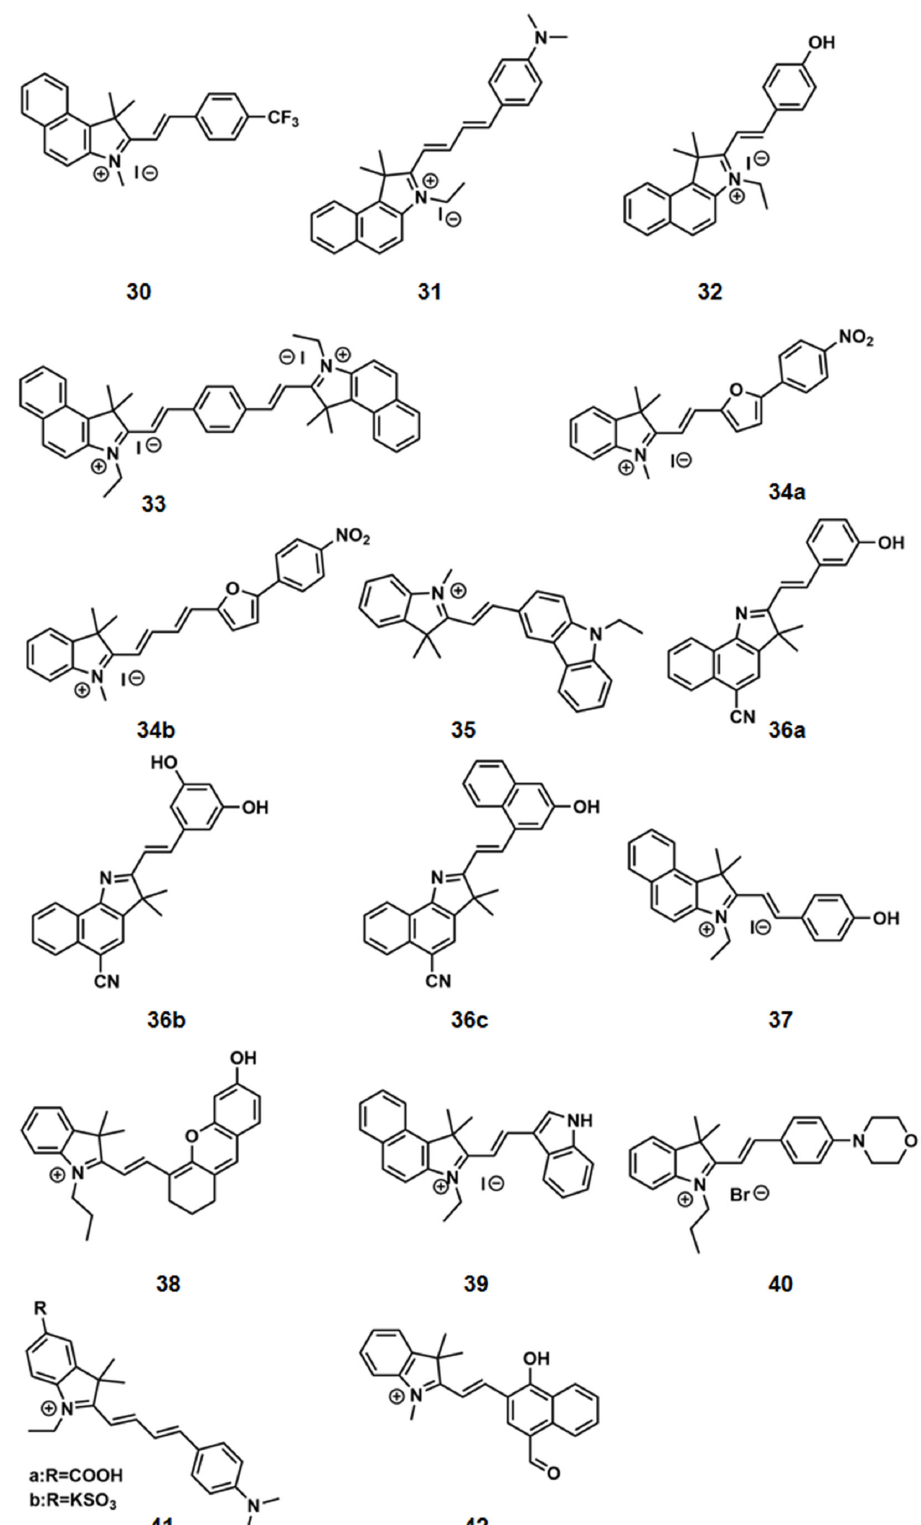
Scheme 8. The formation of sulfite fluorescent probes 30 − 42 .